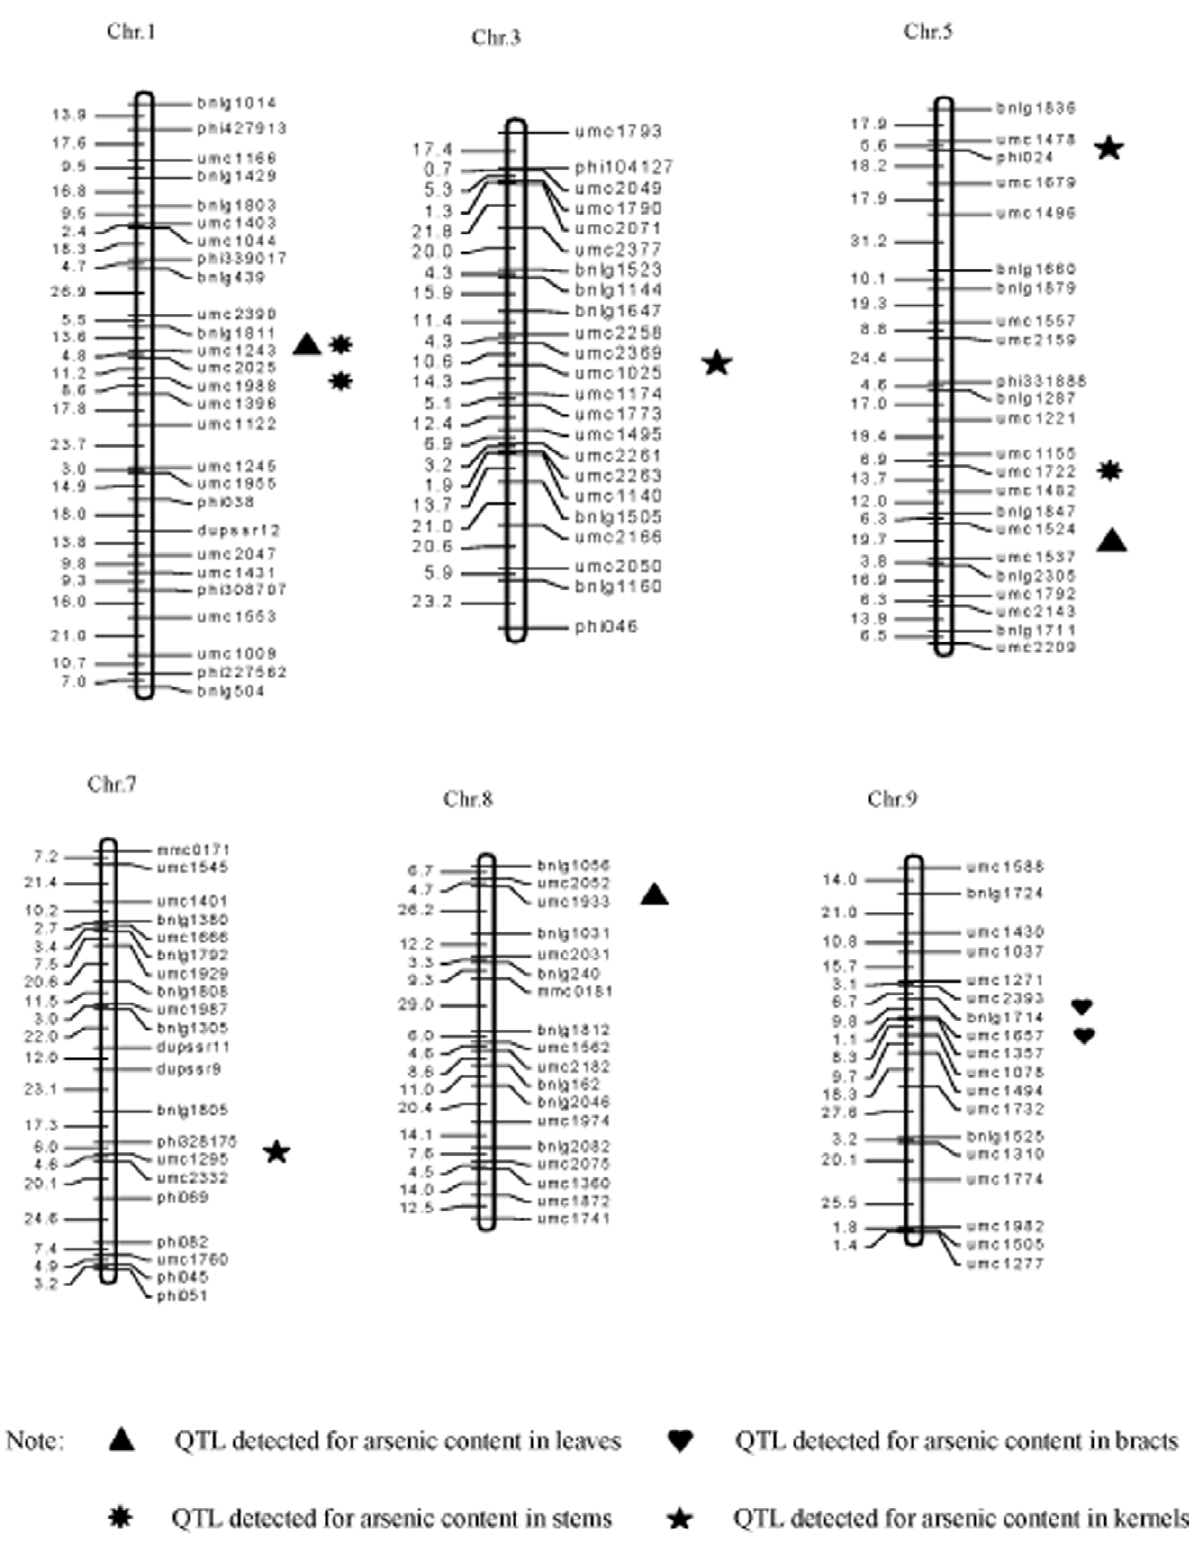
Figure 2. Chromosomal locations of QTLs detected for arsenic concentration for the four measured traits in maize.